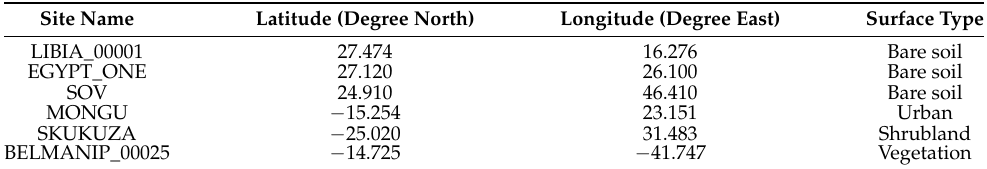
Table 4. SAVS site used for comparison with reference data. Latitude and longitude are given in decimal